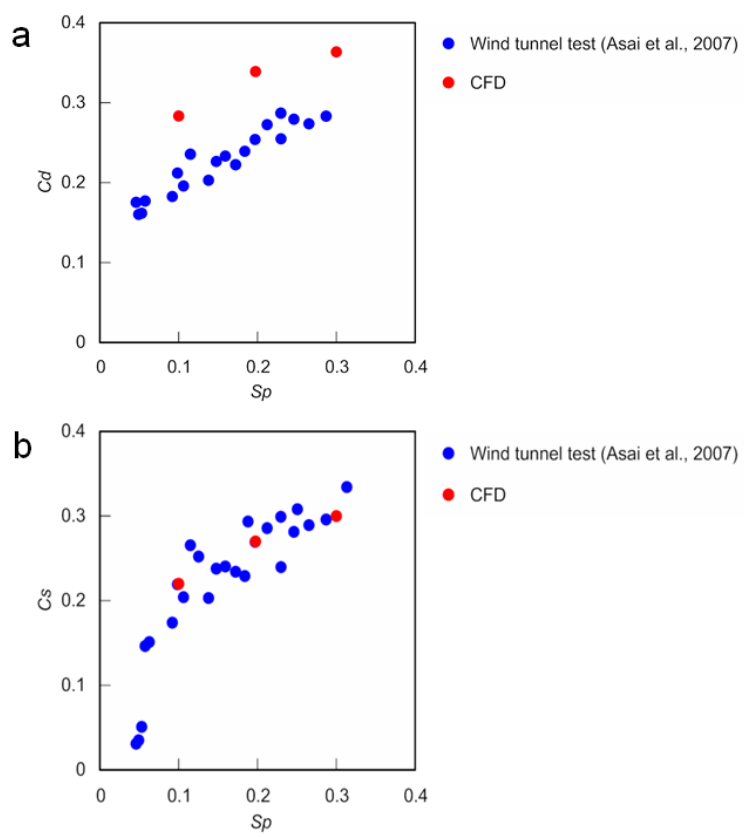
Figure 4. Comparison of ( a ) drag force coefficients and ( b ) side force coefficients of a spinning ball determined from CFD analyses and wind tunnel tests.